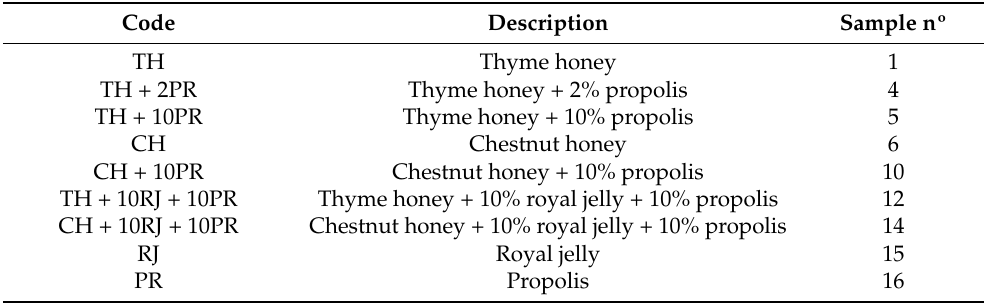
Table 2. Honey and bee product samples and mixtures selected from a previous work